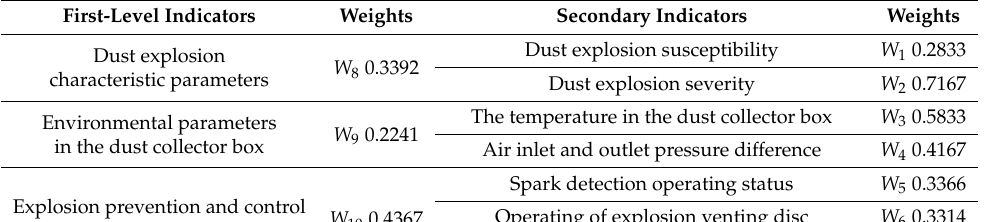
Table 11. The weight of each primary and secondary indicator.